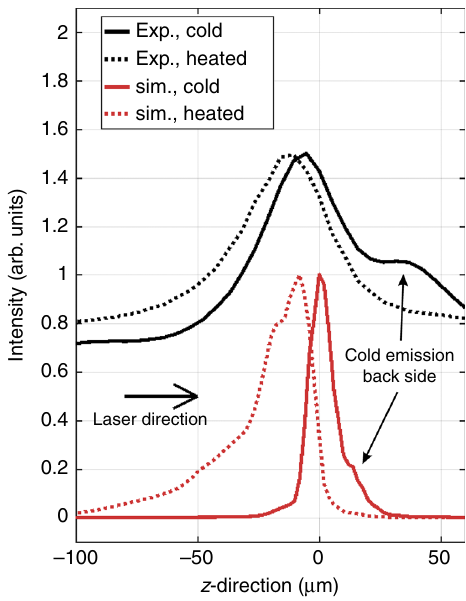
Fig. 6 Spatial pro fi les of X-ray emission from plasma. Comparison of axial distributions of cold and heated K α -emission obtained from the experiment and simulations